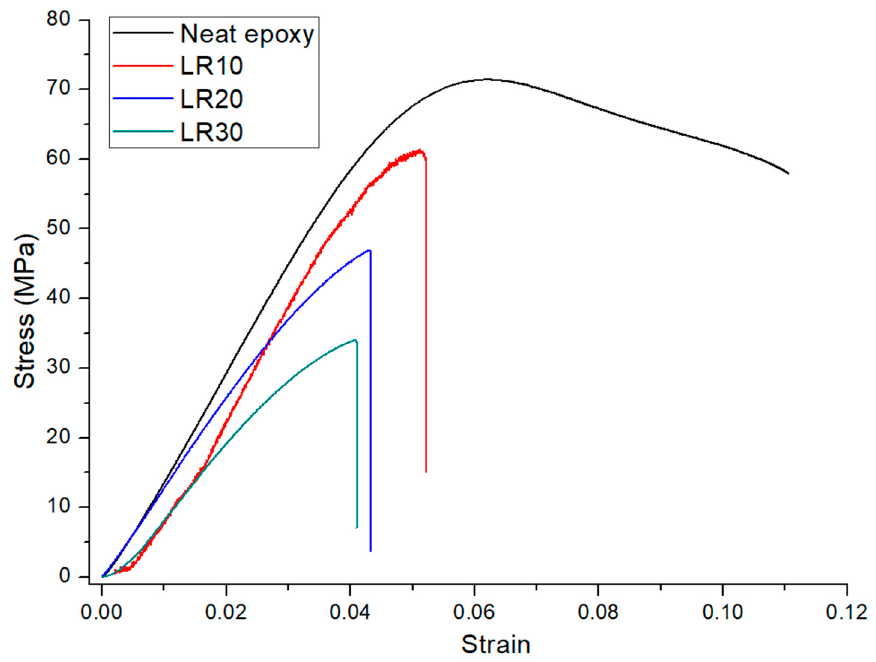
Figure 3. Stress–strain curve of recycled EPDM rubbers modified epoxy-based composites.